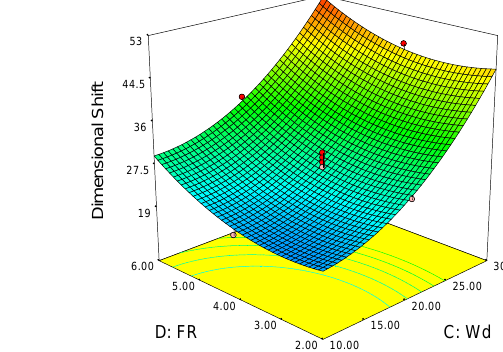
Fig. 8b. Combined effect of W d and SV on D S S on D d Combined effect of FR and W c.8